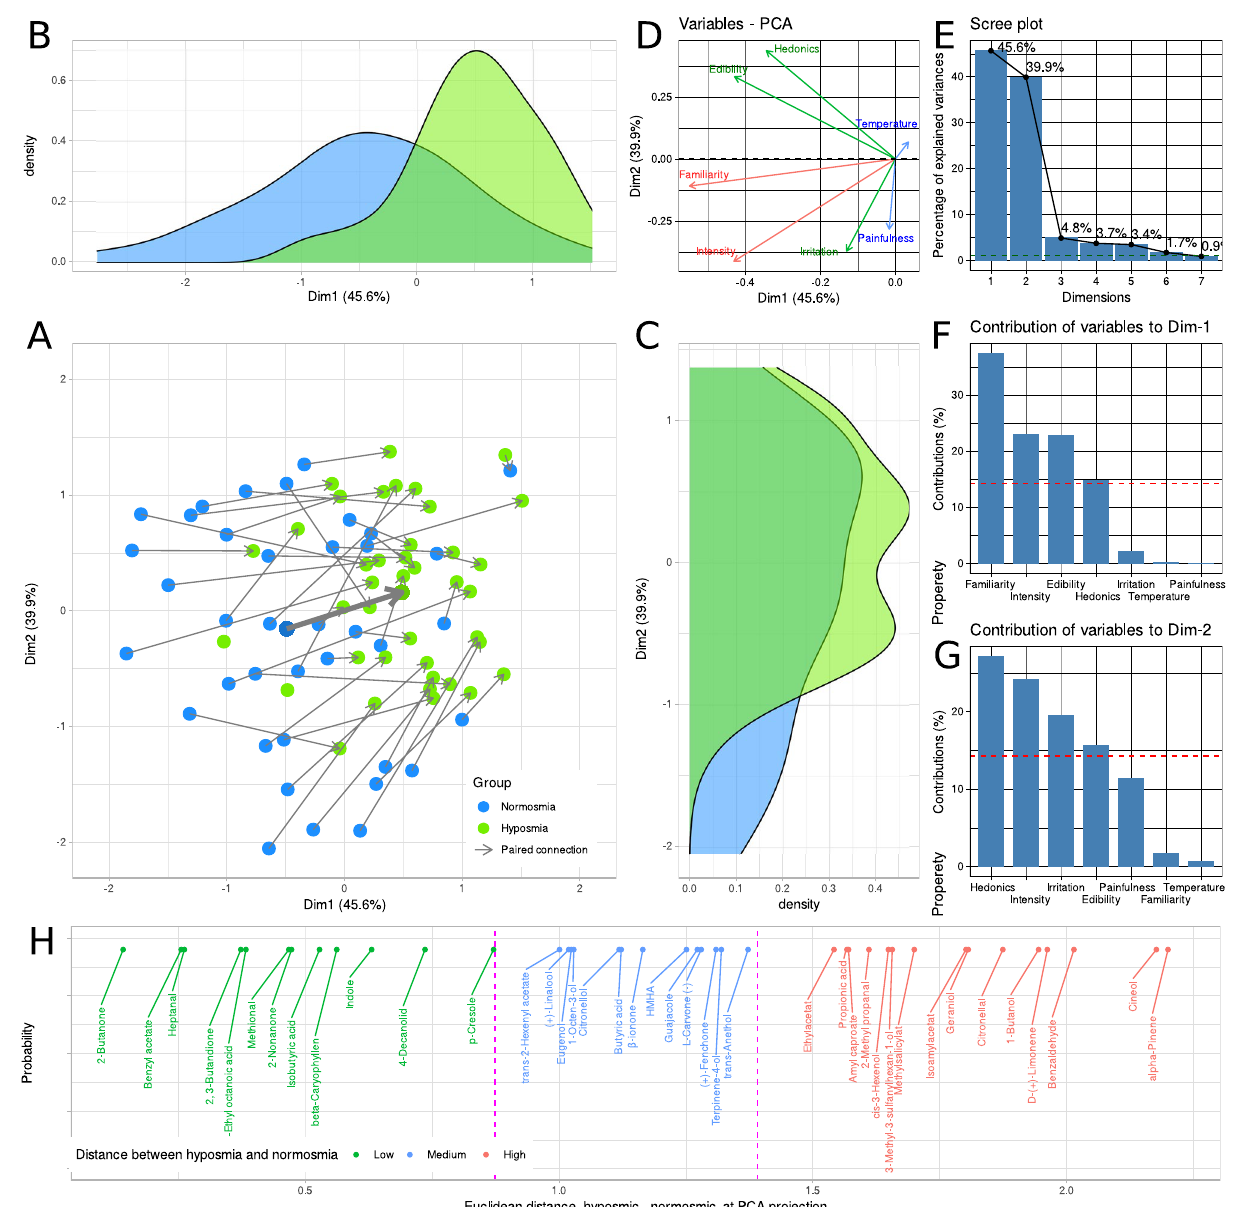
Figure 2. Results of a principal component analysis (PCA). Projection of the 80 × 7 data matrix obtained by averaging the ratings of perceptual odor properties, separately for each of the seven properties, the 40 odors and the 2 olfactory diagnoses. ( A ) Plot of the data projected on the space given by the first two principal components (Dim.1 versus Dim.2). The PCA plot shows the separation of olfactory diagnoses mainly to the right in Dim.1 and to the top in Dim2, see the thick arrow indicating the averages of the PCA coordinates between olfactory diagnoses. The same odors rated by either normosmic or hyposmic subjects are connected with arrows (paired data). ( B,C ) The marginal distribution plots show the segregation of the pain phenotype groups along the principal components. ( D ) Plots the Eigenvectors of a variable in PCA Dim1 versus Dim2. ( C ) Scree-plot of the amount of variance of the data captured by each principal component. ( E ) Bar graph of the explained variance by each principal component. ( F ) Bar graph of the contribution of each perceptual property to Dim.1. The dashed horizontal reference dashed corresponds to the expected value if the contribution where uniform. ( G ) Bar graph of the contribution of each perceptual property to Dim.2. ( H ) Sorted Euclidean distances between the same odors evaluated by either normosmic or hyposmic subjects, i.e., the lengths of the arrows in panel A. The vertical dotted lines show the decision boundaries obtained by ABC analysis of the distances. The figure has been created using the R software package (version 4.0.3 for Linux; https:// CRAN.R- proje ct. org/ (R Development Core Team, 2008)) and the libraries “ggplot2” (https:// cran.r- proje ct. org/ packa ge= ggplo t2 (Wickham, 2009)) and “FactoMineR" (https:// cran.r- proje ct. org/ packa ge= Facto MineR 69